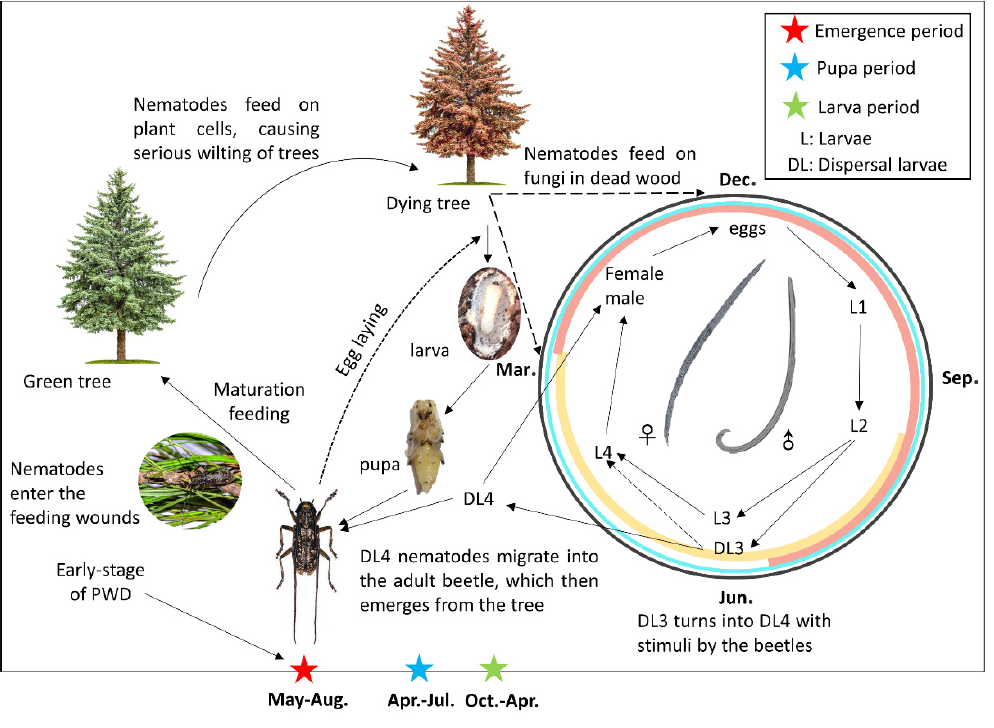
Figure 2. The process of pine wood nematode infection.